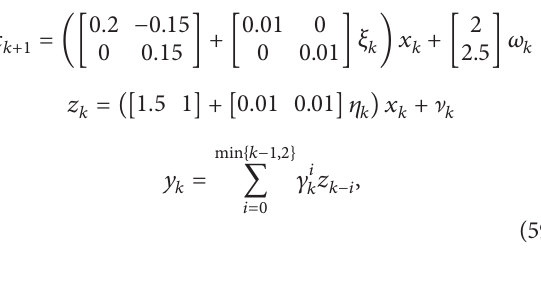
Algorithm 8 (Kalman filtering with multiplicative noises and random two-step sensor